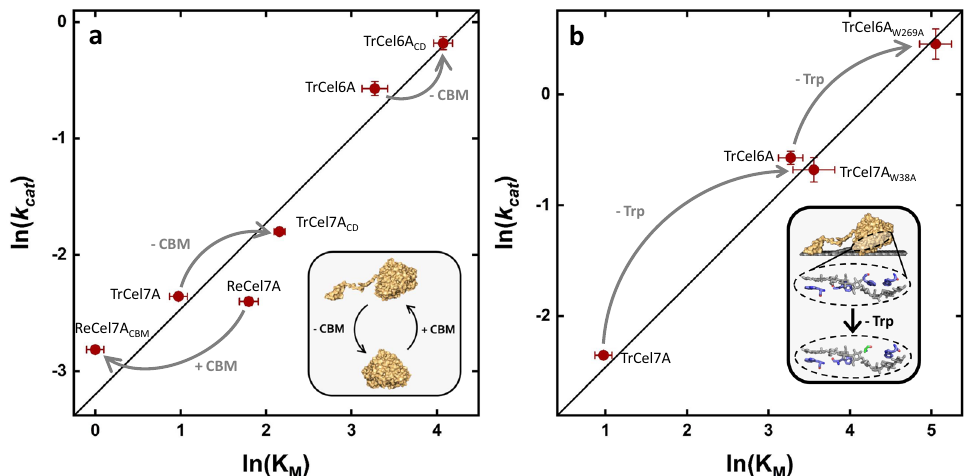
Fig. 4 Illustration of the effect of the non-catalytic CBM (a) and tryptophan residues in the catalytic domain of cellobiohydrolases from GH6 and GH7 (b). a Correlation plot of ln(K M ) and ln(k cat ) for three wild-type CBHs and three variants, where the CBM was either removed ( − CBM) from the wild-type (TrCel7A → TrCel7A CD , TrCel6A → TrCel6A CD ) or added ( + CBM) to the wild type (ReCel7A → ReCel7A CBM ). b Analogous correlation plot for replacements of conserved tryptophan residues by alanine in the catalytic domain of TrCel7A (TrCel7A → TrCel7A W38A ) or TrCel6A (TrCel6A → TrCel6A W269A ). The solid line shown in both plots is the same as in Fig. 2. It appears that changes in K M and k cat tend to compensate so that all enzymes remain close to the diagonal. Inserts are illustrations to guide the reader about the structural changes in the variants. Error bars represent standard deviations from MM- fi t (Eq. 2) to